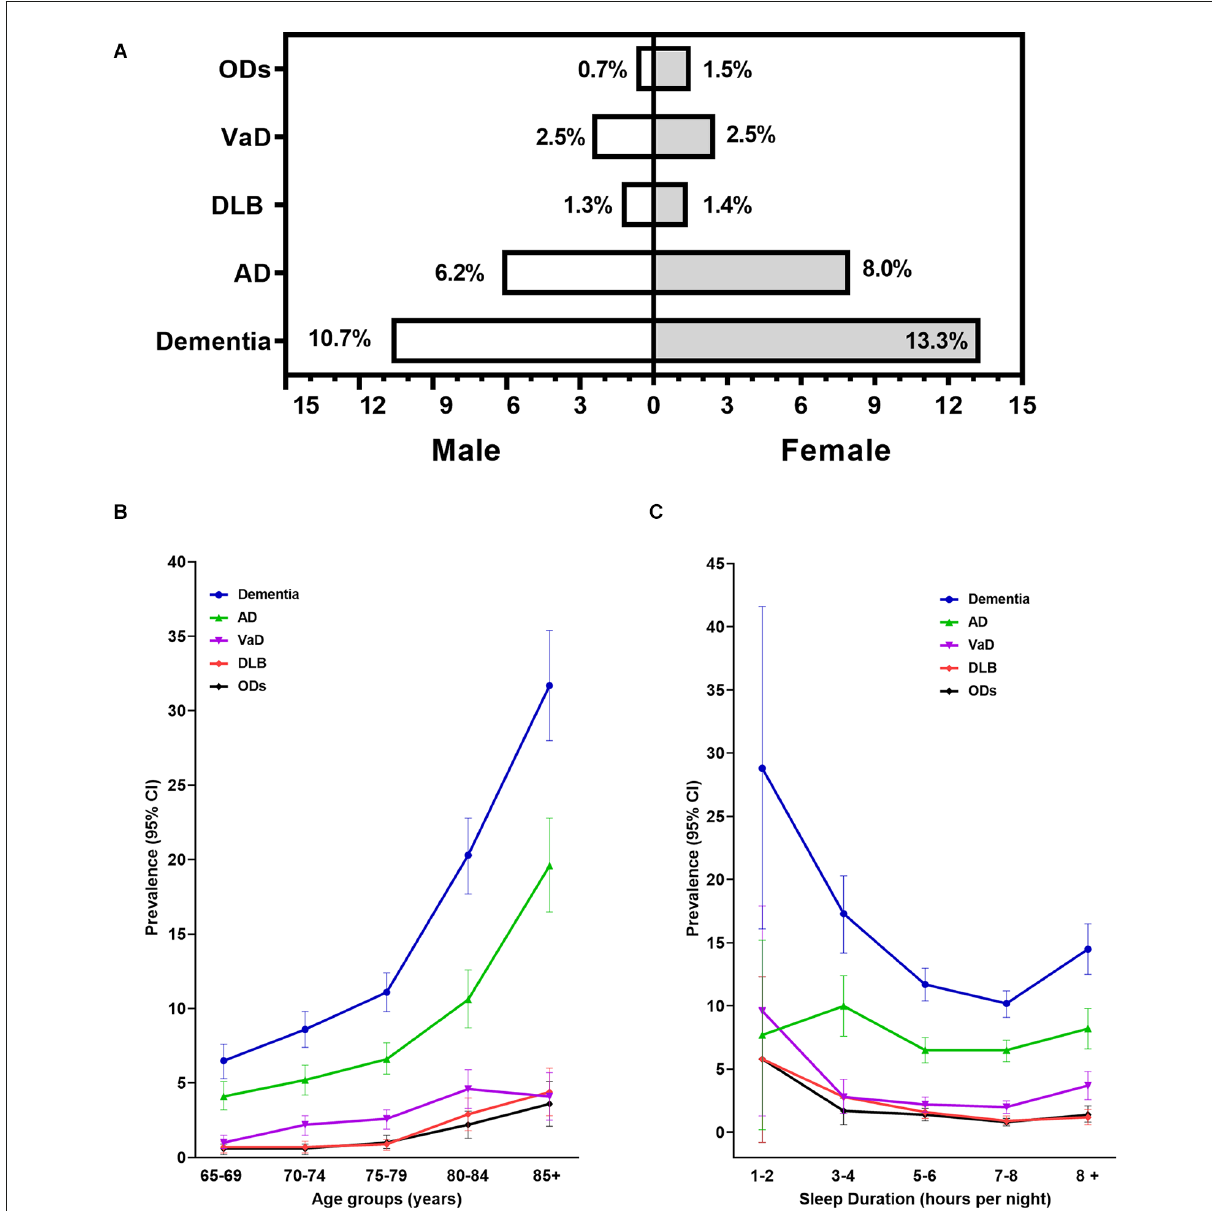
FIGURE2 Prevalence of all-cause dementia and main subtypes by age, gender, and sleep duration categories. Panel (A) showed the crude prevalence rates of dementia and its subtypes. Panels (B,C) showed the prevalence and 95% CI of dementia and its subtypes by age and sleep duration categories. 95% CI, 95% confidence interval; AD, Alzheimer’s disease; VaD, vascular dementia; DLB, dementia with Lewy bodies; ODs, other dementia.